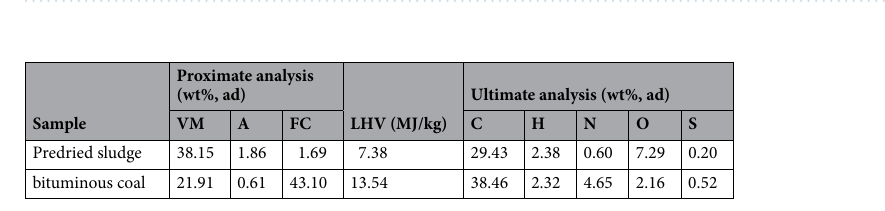
Table 3. Ultimate and proximate analyses of predried ES and bituminous coal. VM volatile matter, A ash, FC fixed carbon.